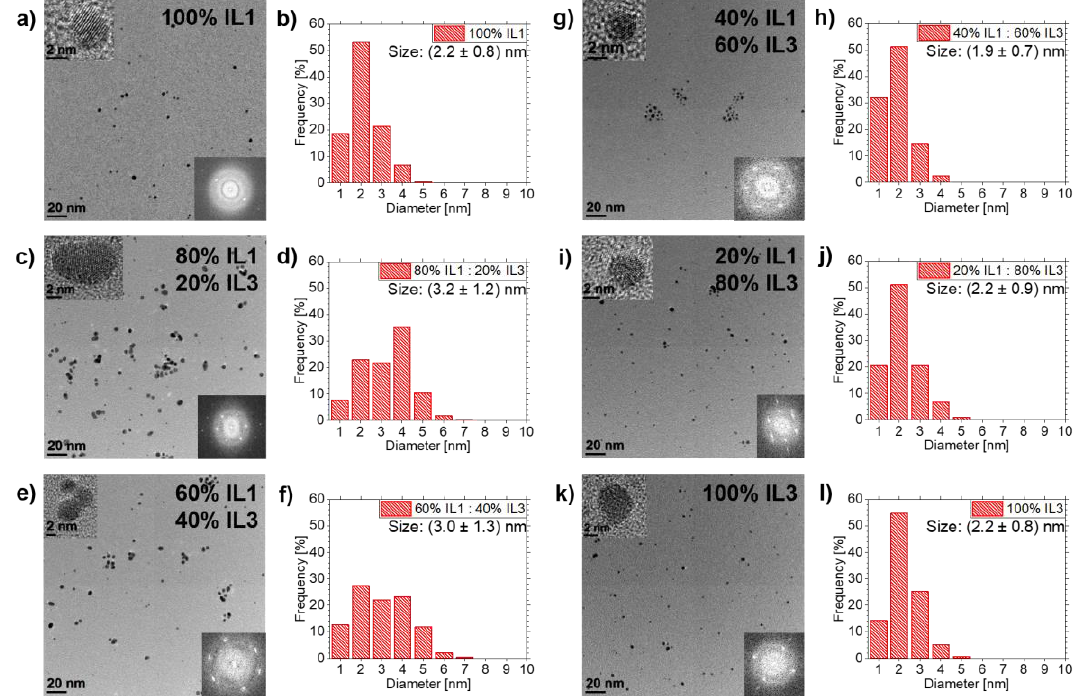
Figure 5. Overview of TEM results of Au NPs sputtered in IL1 / IL3 -mixtures and pure ILs as references. TEM images and the corresponding NP size distribution are depicted in ( a , b ) for pure IL1 . Overview images and NP size distributions for IL1 / IL3 -mixtures are shown in ( c , d ) for 80 vol.% IL1 / 20 vol.% IL3 , in ( e , f ) for 60 vol.% IL1 / 40 vol.% IL3 , in ( g , h ) for 40 vol.% IL1 / 60 vol.% IL3 and in ( i , j ) for 20 vol.% IL1 / 80 vol.% IL3 . Results of pure IL3 are illustrated in ( k , l ). HRTEM images of NPs from the particular investigated IL (mixtures) and corresponding FFT images are depicted as insets in the overview images, confirming NP crystallinity due to visible lattice fringes and corresponding spots in the FFTs.